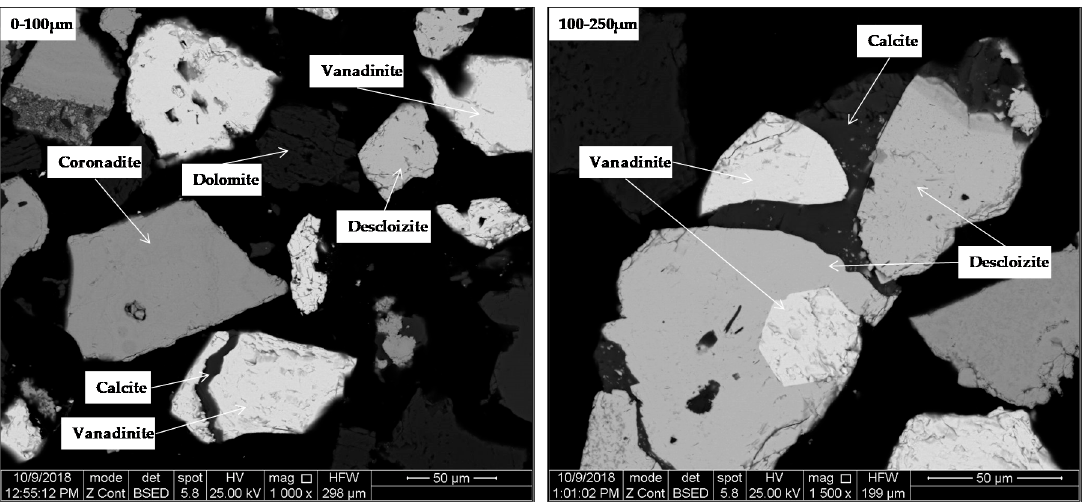
Figure 9. BSE images of particle size fractions of the pre-concentrate from the plant. Left : <100 µm; right : 100–250 µm.